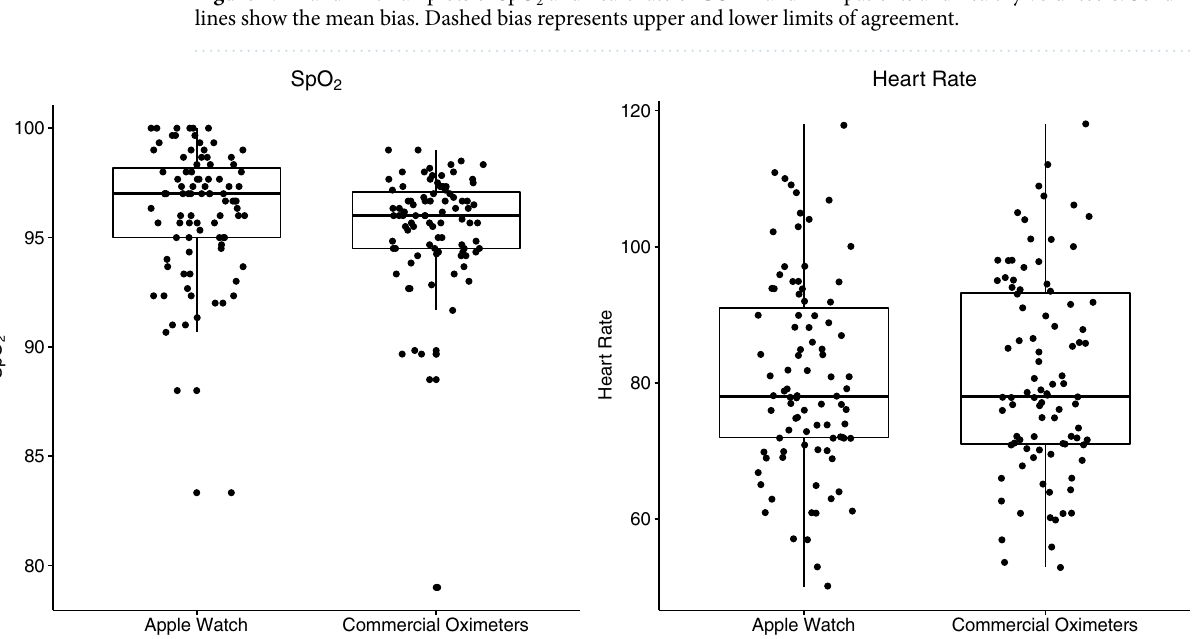
Figure 3. Comparison of Apple Watch and commercial oximeters devices of SpO 2 and heart rate of COPD and ILD patients and healthy